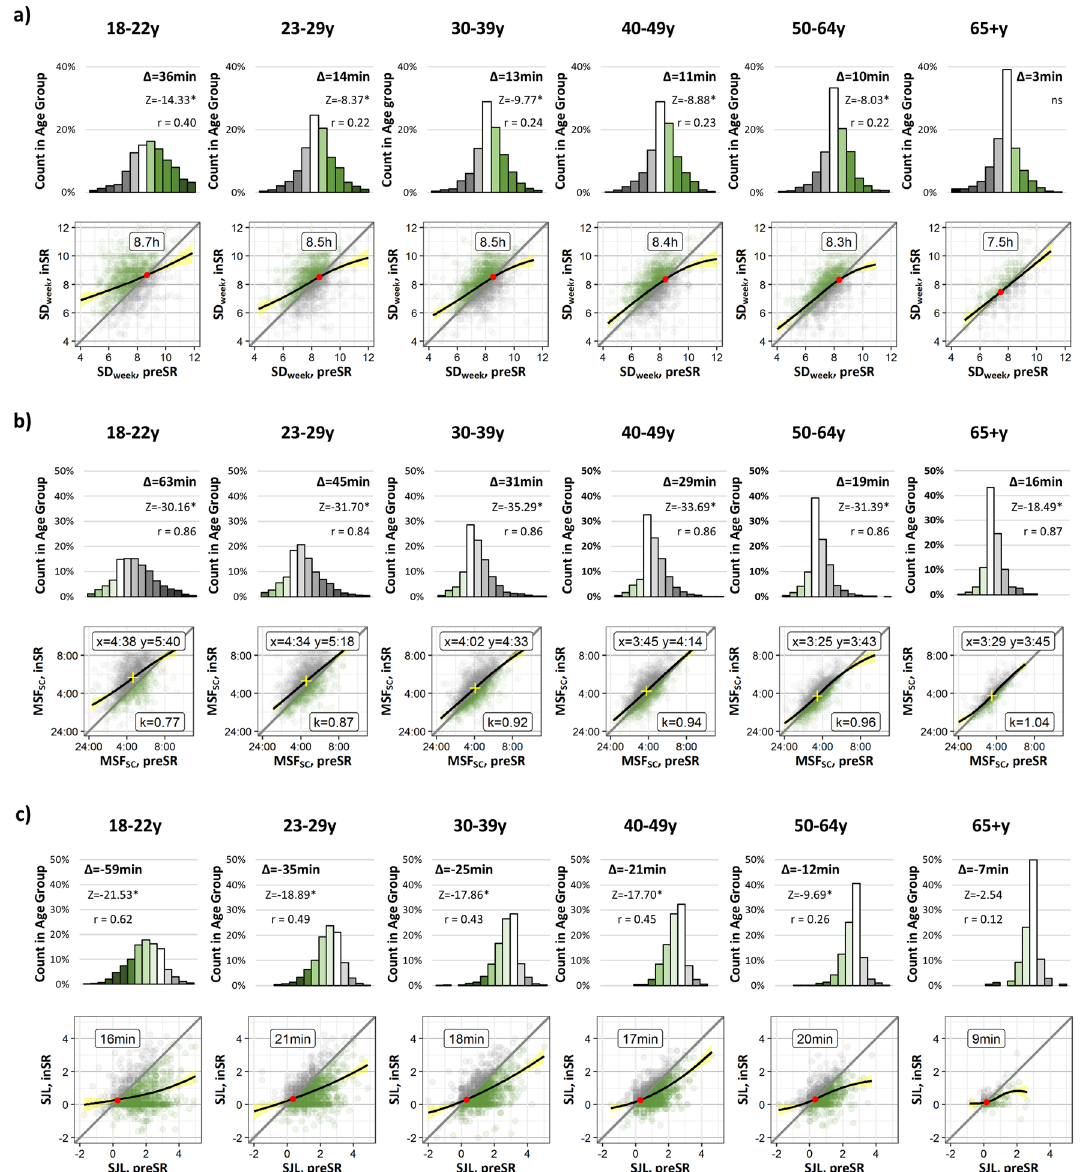
Figure 2. Social restriction-induced changes ( preSR → inSR ) in sleep–wake behavior by age-group (18–22y, 23–29y, 30–39y, 40–49y, 50–64y, and 65 + y). Upper panels—distributions of ( a ) delta of sleep duration, ∆SD week , ( b ) delta of corrected mid-sleep time on free days, ∆MSF sc (chronotype), ( c ) delta of social jetlag, ∆SJL. The magnitude of shifts is represented in 0.5 h color-coded bins, with white bars representing no change, green bar—increase in SD week , advance in MSF sc and decrease in SJL, grey bars—decrease in SD week , delay in MSF sc and increase in SJL. Mean ∆ in minutes and Z statistic of the post-hoc Wilcoxon Signed Ranks two-tailed tests for each parameter are shown above the bars. *p < 0.001, r effect size, ns non-significant. Lower panels—Scatterplots of individual shifts in ( a ) SD week (h), ( b ) MSF sc (chronotype, local time), and ( c ) SJL (h), preSR (x axis) vs. inSR (y axis). Notations—as in Fig.